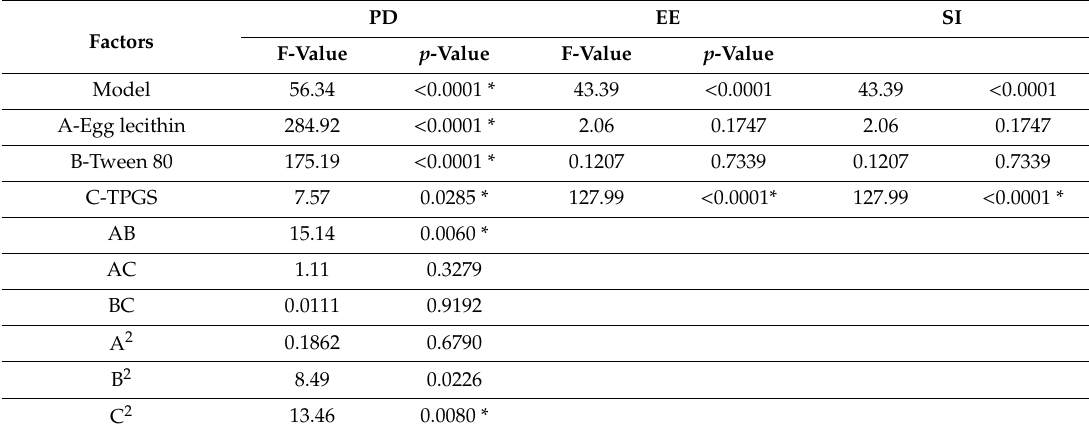
Table 4. Independent factors for the estimated e ff ects, F-ratio, and associated p -values for the NTS.